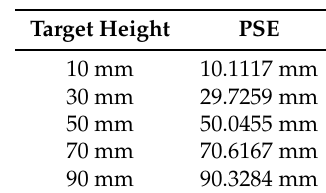
Table 1. Mean heights in mm for height judgement task.